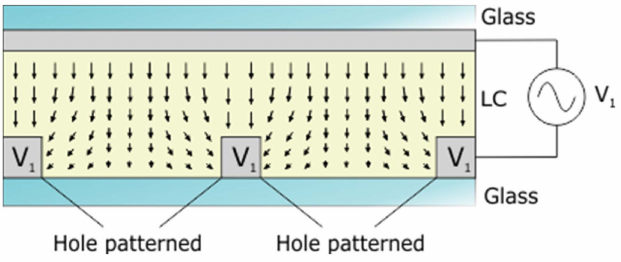
Figure 10. Structure of a liquid crystal microlens based on hole patterned